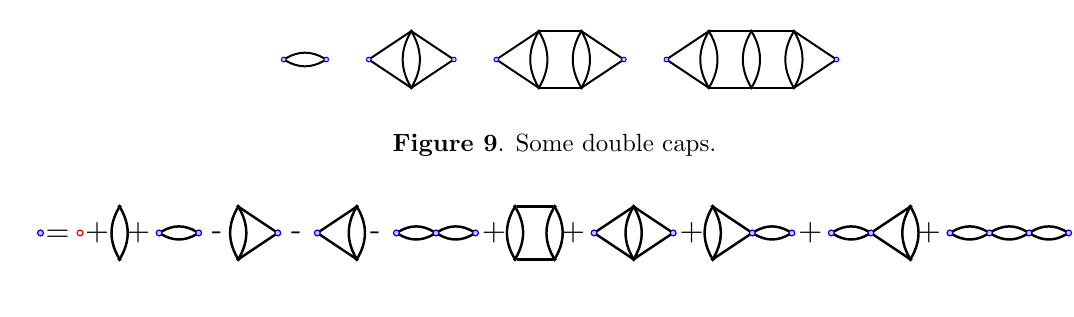
Figure 10 . The renormalized series by iterated substitutions. On the right hand side the vertices (cid:21) 1 (in blue) should be iteratively substituted with the right hand side